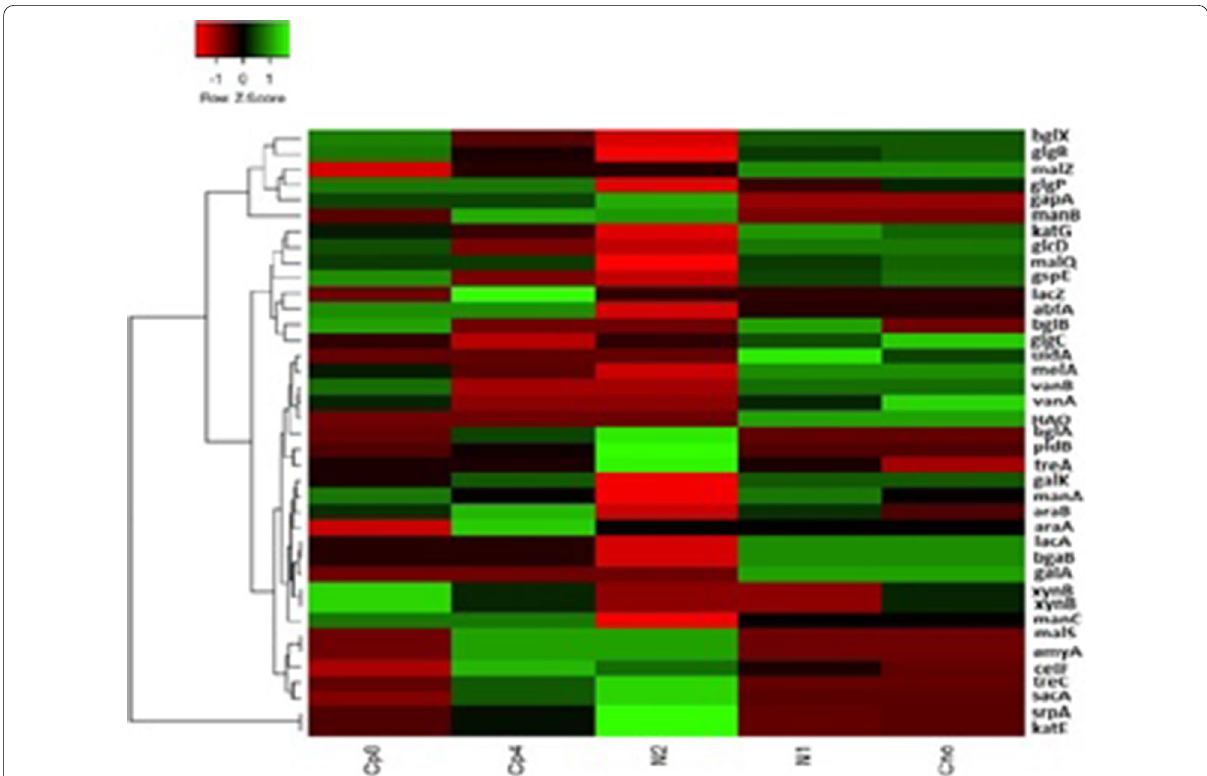
Fig. 6 Relative abundance of carbon cycling genes present at maize rhizosphere under fertilization treatments. The abbreviations meaning are ( amyA ) alpha-amylase, ( glgB ) 1,4-alpha-glucan branching enzyme, ( bglX ) beta-glucosidase, ( glgP ) starch phosphorylase, ( manB ) phosphomannomutase, ( gapA ) glyceraldehyde 3-phosphate dehydrogenase, ( malZ ) alpha-glucosidase, ( malQ ) 4-alpha-glucanotransferase, ( gspE ) general secretion pathway protein E, ( katE ) catalase, ( glgC ) glucose-1-phosphate adenylyltransferase, ( bglB ) beta-glucosidase, ( manC ) mannose-1-phosphate guanylyltransferase, ( manA ) mannose-6-phosphate isomerase, ( lacZ ) beta-galactosidase, ( xynB ) xylan 1,4-beta-xylosidase, ( galK ) galactokinase, ( araB ) L-ribulokinase, ( araA ) L-arabinose isomerase, ( lacA ) beta-galactosidase, ( glcD ) glycolate oxidase, ( vanA ) vanillate monooxygenase, ( vanB ) vanillate monooxygenase, ( srpA ) catalase, (HAO) (S)-2-hydroxy-acid oxidase, ( treA ) alpha,alpha-trehalase, ( sacA ) beta-fructofuranosidase, ( treC ) trehalose-6-phosphate hydrolase, ( xynB ) xylan 1,4-beta-xylosidase, ( pldB ) lysophospholipase, ( uidA ) beta-glucuronidase, ( bgaB ) beta-galactosidase, ( abfA ) alpha-N-arabinofuranosidase, ( galA ) alpha-galactosidase, ( melA ) alpha-galactosidase, ( malS ) alpha-amylase, ( bglB ) beta-glucosidase, ( bglA ) 6-phospho-beta-glucosidase, ( celF ) 6-phospho-beta-glucosidase, ( katG )